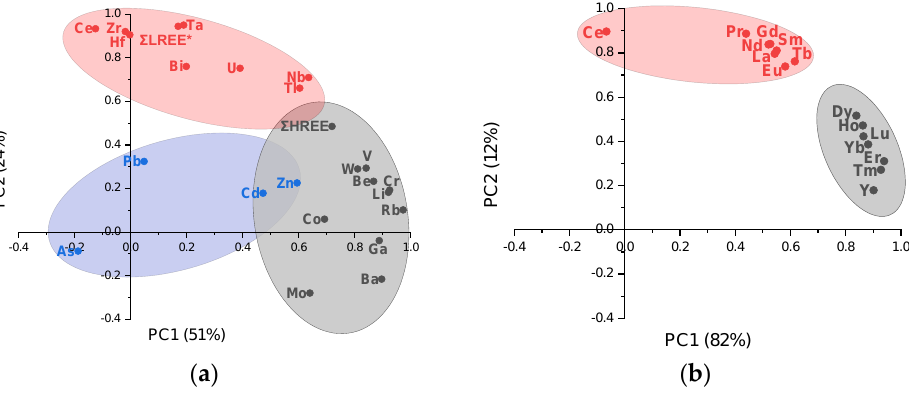
Figure 6. Loading of PC1 versus PC2 factors from TE, RE, Ce, ΣLREE * , and ΣHREE ( a ) and REE ( b ) quantified in the sediment samples of Podu Iloaiei Dam Lake (loading values are presented in Tables S3 and S4 in the Supplementary Materials).